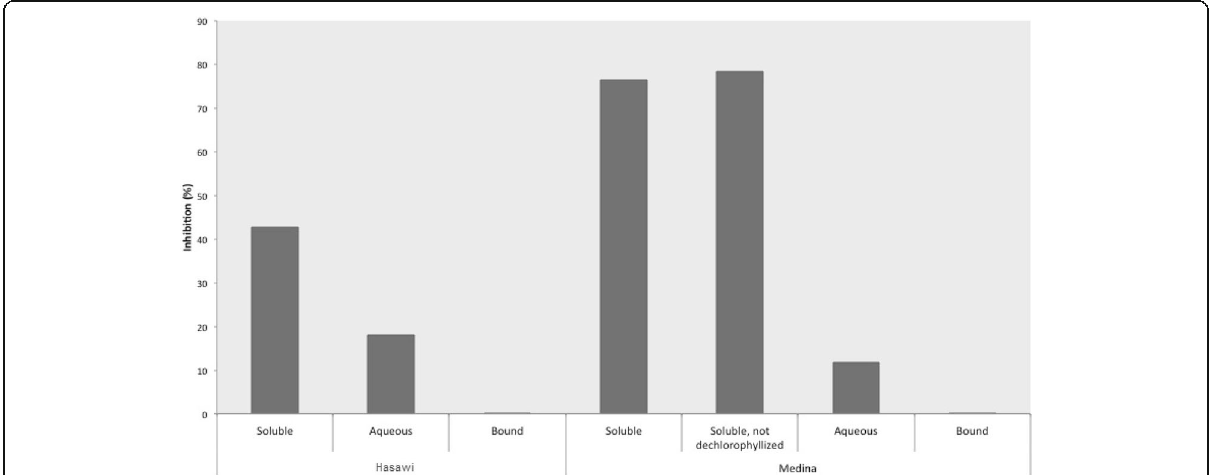
Fig. 2 Percentage inhibition of DNA scission by Medina and Hasawi mint. Percent inhibition was determined from the normalized ratio of supercoiled to open circular DNA for each sample. DNA scission was induced by peroxyl radical (AAPH at a final concentration of 12 mM) and kept at 37 °C for 1 h